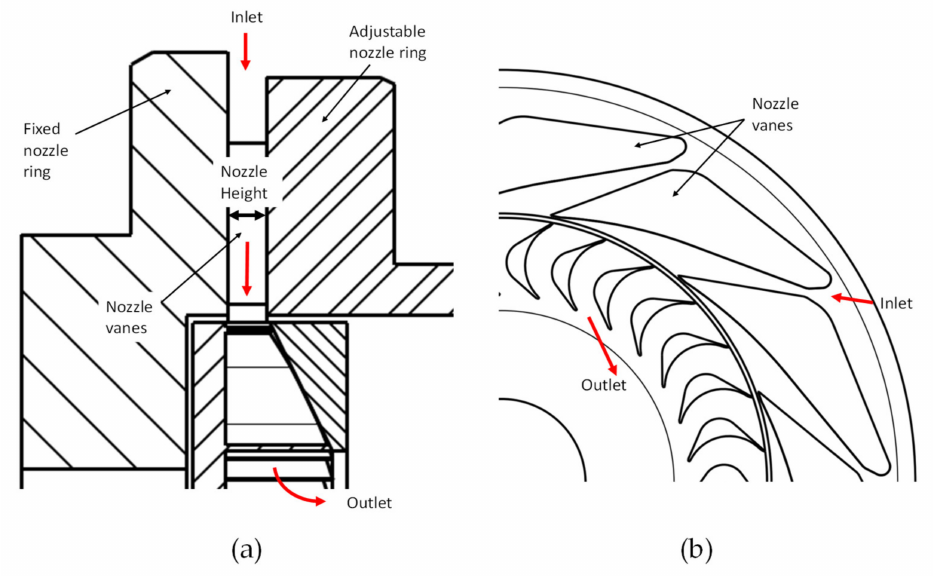
Figure 1. Meridional cut ( a ) and blade-to-blade cut ( b ) of the implemented adjustable nozzle height